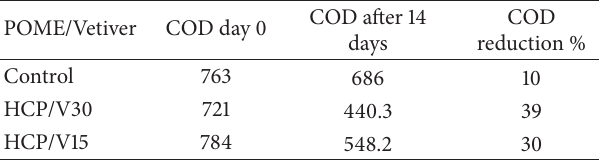
Table 4: Reduction of BOD in low concentration POME with different Vetiver density.